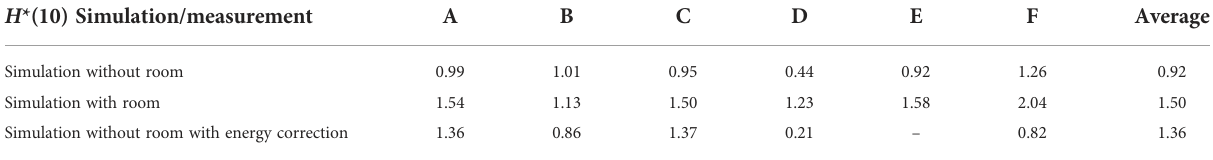
TABLE 4 Overview of the average ratio of simulated over measured H*(10) per position and averaged over all positions for the Skandion measurement campaign. H *(10)